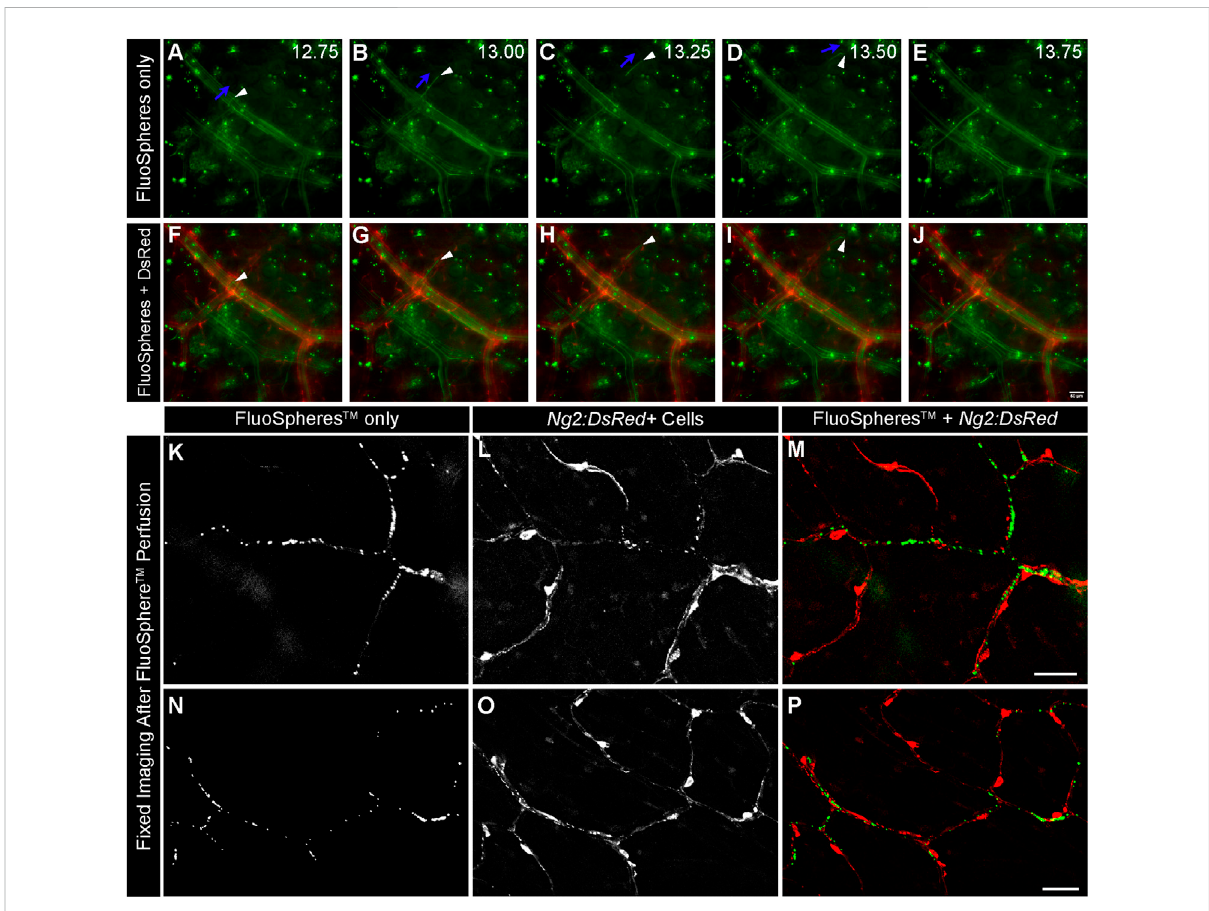
FIGURE 2 Green FluoSpheres TM Perfuse Ng2:DsRed -labeled Intestinal Capillaries. Representative time-lapse images of fl uorescent green microspheres [green in (A – J) , 1 μ m in diameter] suspended in PBS traveling through the intestinal vasculature via feeder artery catheterization in an Ng2:DsRed reporter mouse [red, in (F – J) ]. An artery-vein pair is shown, in which the vessels are distinguished by the presence of DsRed in the NG2+ smooth muscle cells wrapped around the artery (F – J) . Green microspheres are observed traveling through both the artery and the vein, validating that thespheresareadvancingdowntothemicrovasculature.Thedirectionalityofonesphereislabeledwithbluearrows,andthesphereisindicatedbya white arrowhead in panels (A – D) . Capturing the phenomenon of a single 1 μ m sphere fl owing through a smaller-order vessel further supports the idea that our mechanism of providing fl ow is able to advance to the microvascular level. Time is shown in seconds (A – E) . Scale bar in (J) is 50 μ